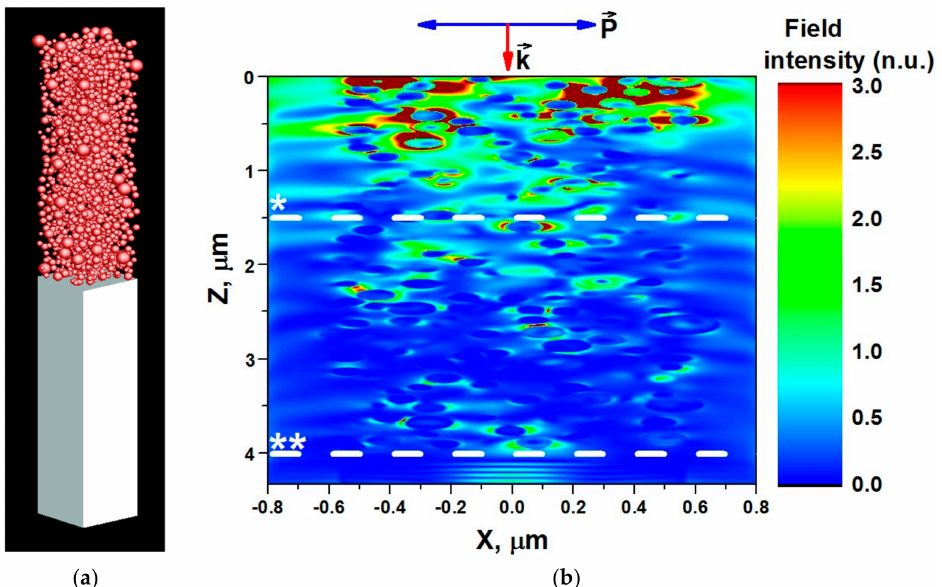
Figure 2. FDTD simulated ( a ) nanogranular porous Si NP film on a continuum SiO 2 glass substrate, and ( b ) in − depth distribution of incoming light (532 nm wavelength) field intensity in normalized units (n.u.) in the nanogranular porous Si NP film (70% porosity, 4 µ m depth (along z-direction) and (1.6 µ m × 1.6 µ m) lateral area within xy-plane with the laser beam diameter (2 µ m) fitting into this lateral area). The incident laser beam is shown with wave-vector depth of the incoming light (532 nm), ** porous Si NP film/silica glass substrate